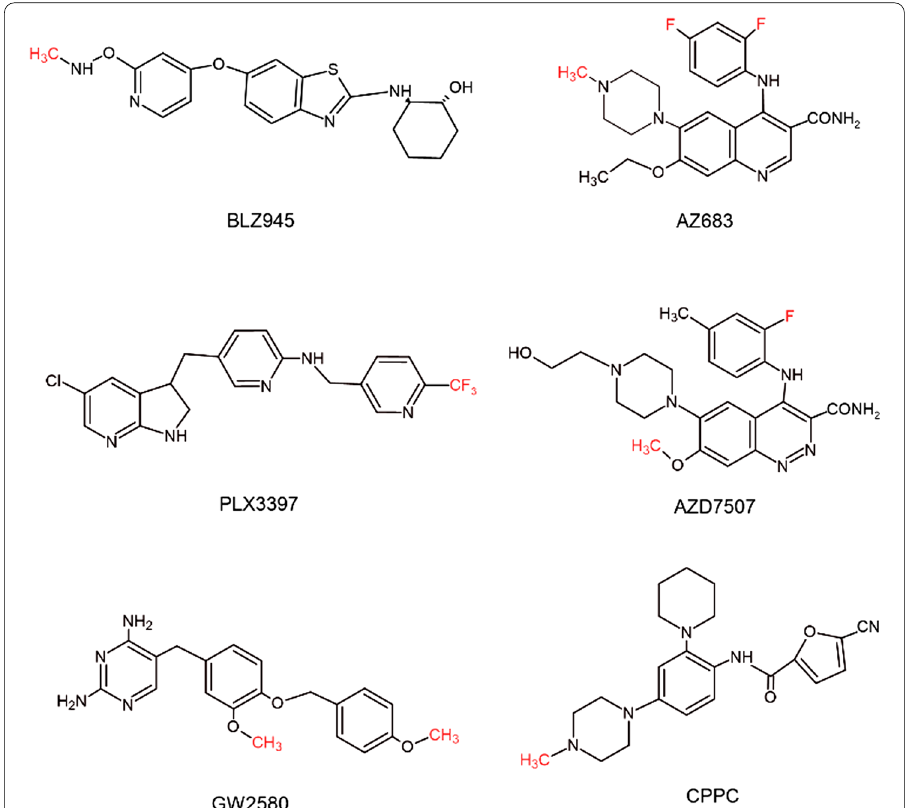
Fig. 2 Structures of representative receptor ligands of the CSF-1R. The positions of the CSF-1R ligands that have been radiolabeled and evaluated as candidate PET tracers are highlighted in red. CSF-1R: colony stimulating factor 1